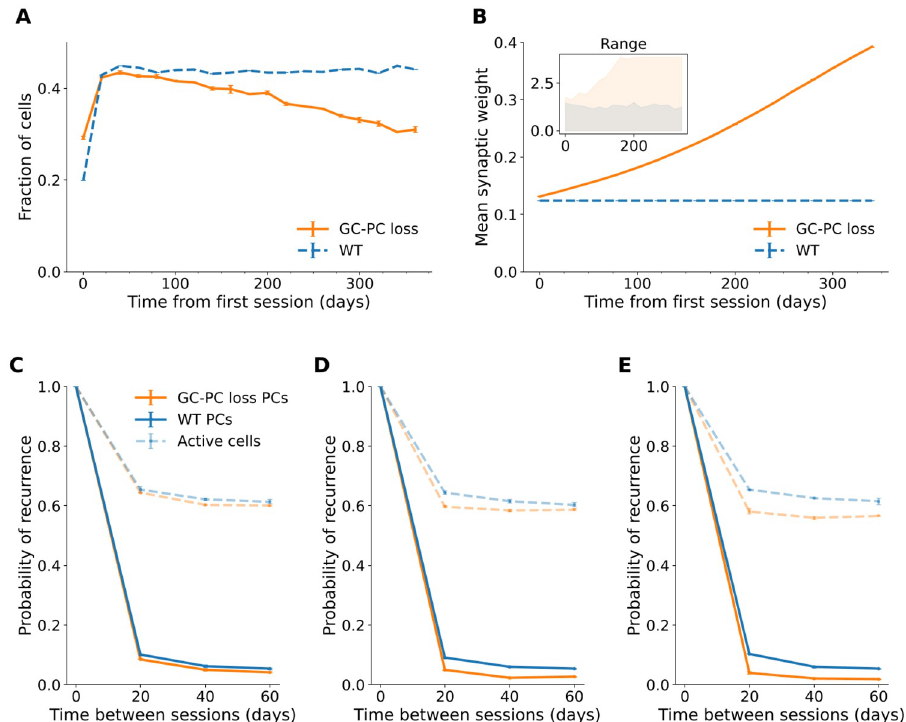
Fig 4. Place cell proportion and place map stability decreased as excitatory synapses were lost. (A) Proportion of place cells over 365 days in the grid-to-pyramidal-cell (GC-PC) synapse loss and wildtype (WT) model. Error bars show standard deviation across two runs of the simulation. (B) Mean synaptic weight over 365 days. Error bars show pooled standard error of all synaptic weights over two runs of the simulation. Inset: Range of weights in the GC-PC loss model (orange) and the wildtype (blue). (C-E) Probability of recurrence for place cells and active cells across sessions 20 to 60 days apart from day 20 (C), day 200 (D) and day 300 (E). Error bars show standard deviation across two runs of the